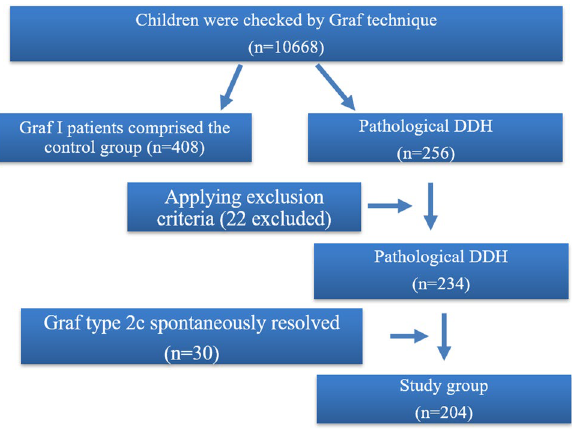
Figure 1. Schematic diagram showing the study design. DDH, developmental dysplasia of the hip.